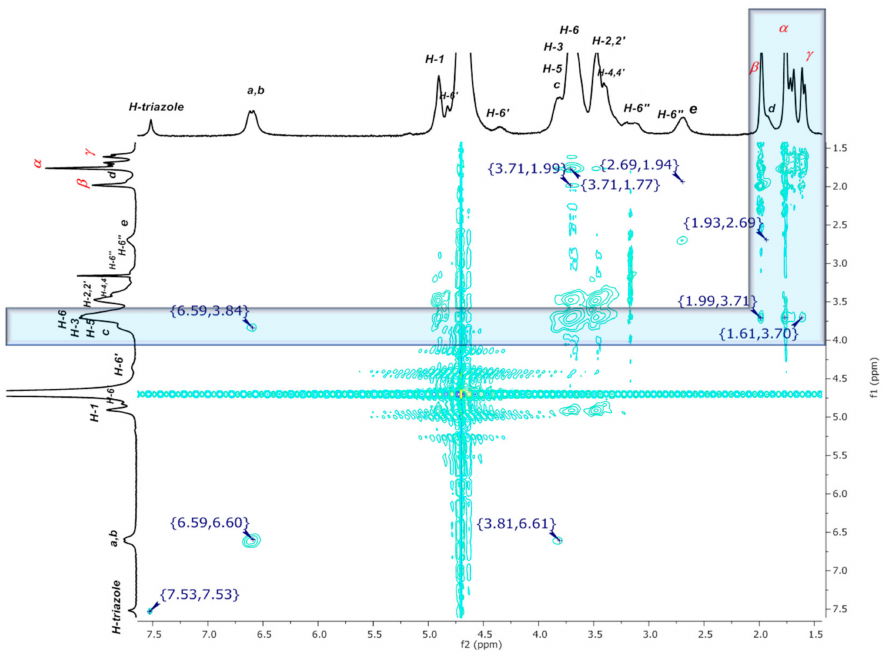
Figure 11. 2D NMR NOESY spectrum of inclusion complex P 3 N 3 -[O-C 6 H 4 -O-(CH 2 ) 3 - β CD] 6 ( I )/AdCOOH in D 2